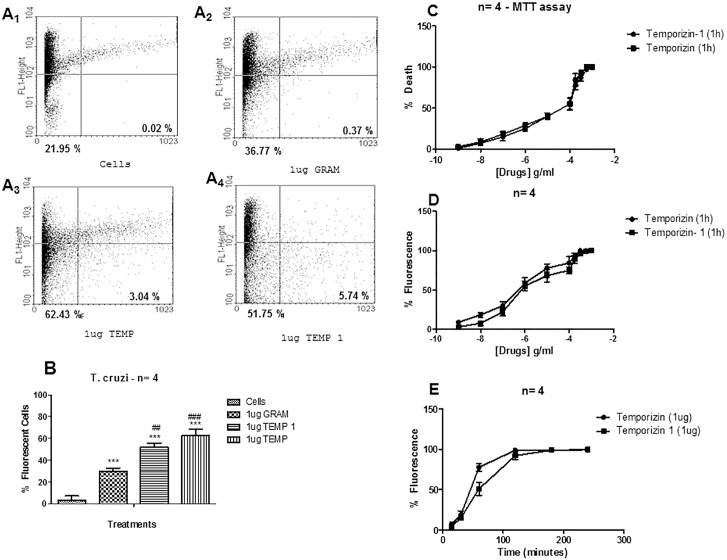
Temporizin-1 possesses toxicity against T. cruzi.A: T. cruzi was incubated at 37°C for 60 minutes for a flow cytometry assay. A single dose of 1 μg/ml was applied to compare the efficiency of the gramicidin (A2), temporizin A (A3) and temporizin-1 (A4) peptides in killing T. cruzi. B: A quantification of the results obtained in A. C: MTT assay using varied concentrations of temporizin and temporizin-1 for 60 minutes. D: PI entry quantification after the treatment with crescent temporizin and temporizin-1 doses for 60 minutes. E: Temporal assay after treatment with 1 μg/ml temporizin and temporizin-1. The values represent the mean ± SD of three to five experiments (flow cytometry and cell permeabilization assay) and three experiments (MTT assay) performed on different days. *p<0.05, **p<0.01 compared with the corresponding negative control.